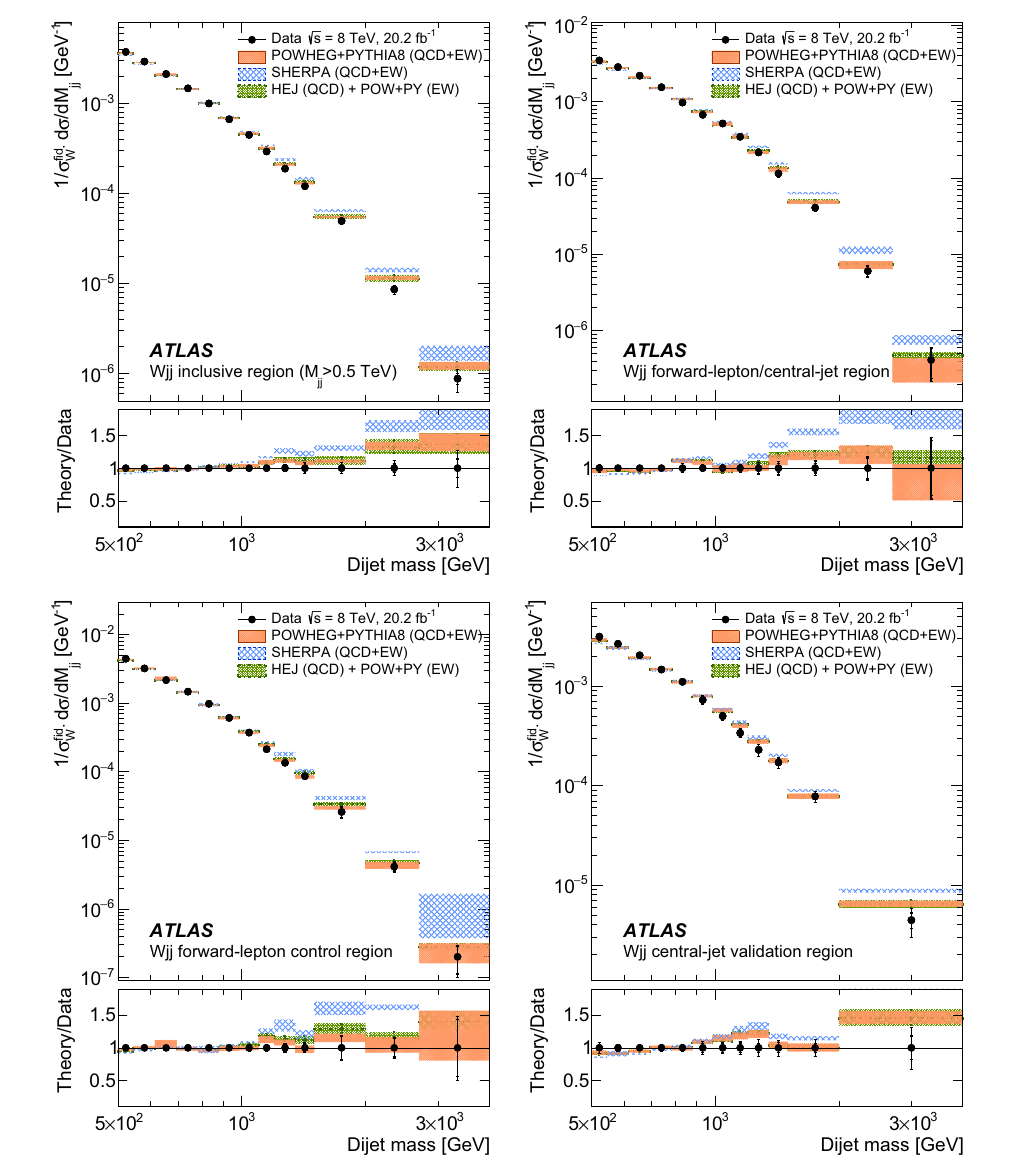
Fig. 17 Unfolded normalized differential W jj production cross sec- tions as a function of dijet invariant mass in the inclusive, forward- lepton/central-jet, forward-lepton, and central-jet fiducial regions. Both